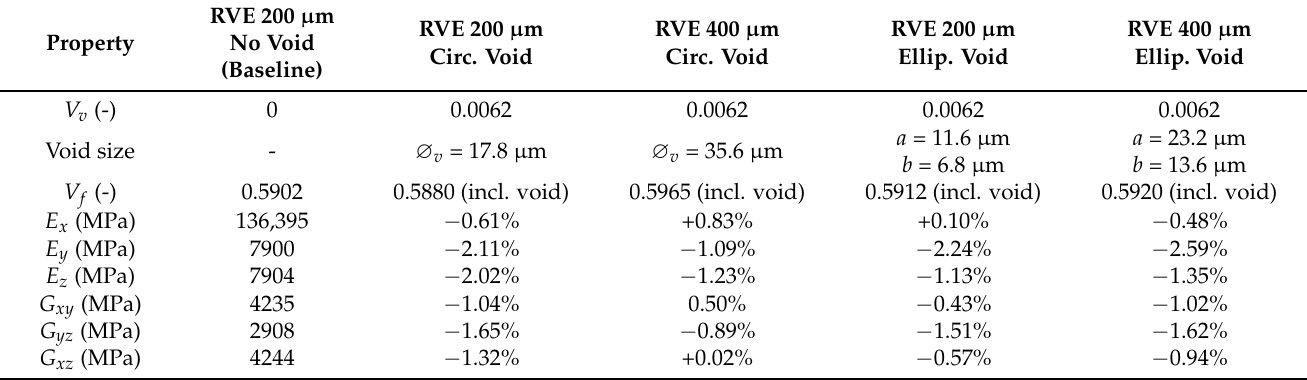
Table 8. Comparison of the average effective macromechanical properties maintaining the void volume fraction. The 200 µ m RVE without a void is considered as the baseline. Only Young’s modulus and the shear modulus are presented; due to a very low variation, Poisson’s ratio is not